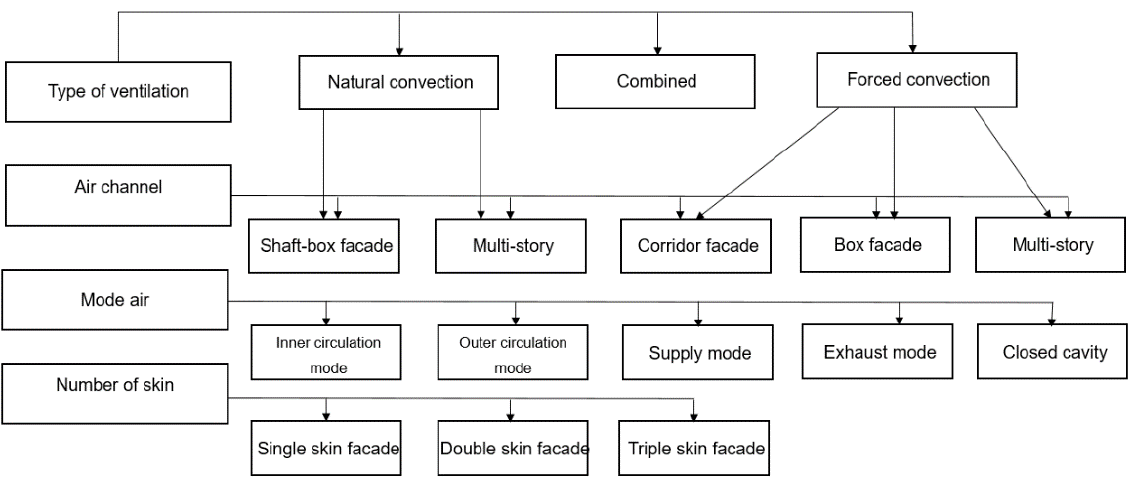
Figure 8. Classification of ventilated